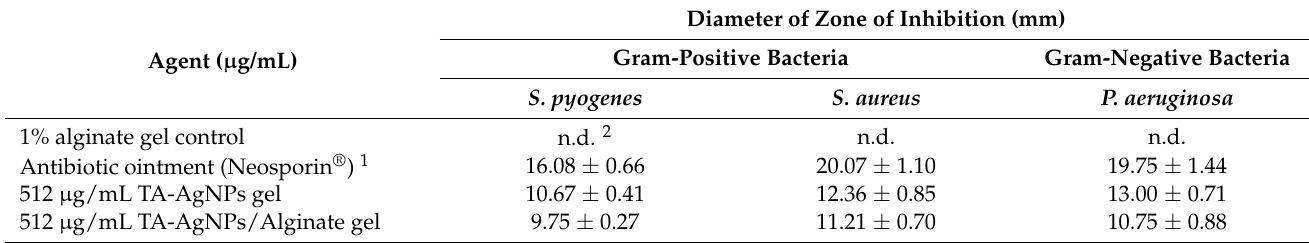
Table 4. Diameter of zone of inhibition of TA-AgNPs gel against bacteria causing wound infection.